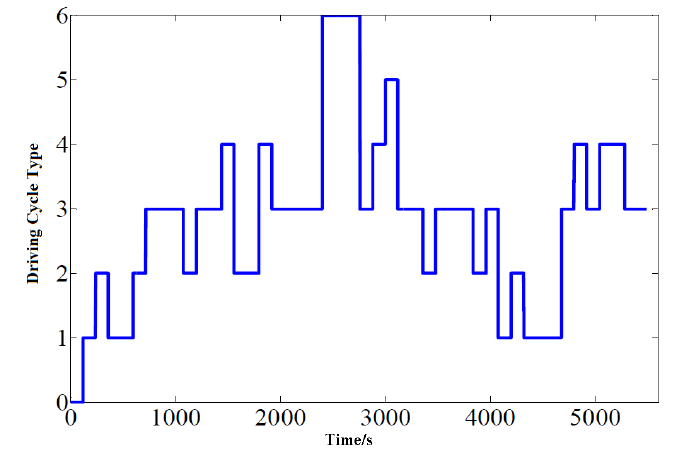
Figure 11. Driving pattern recognition